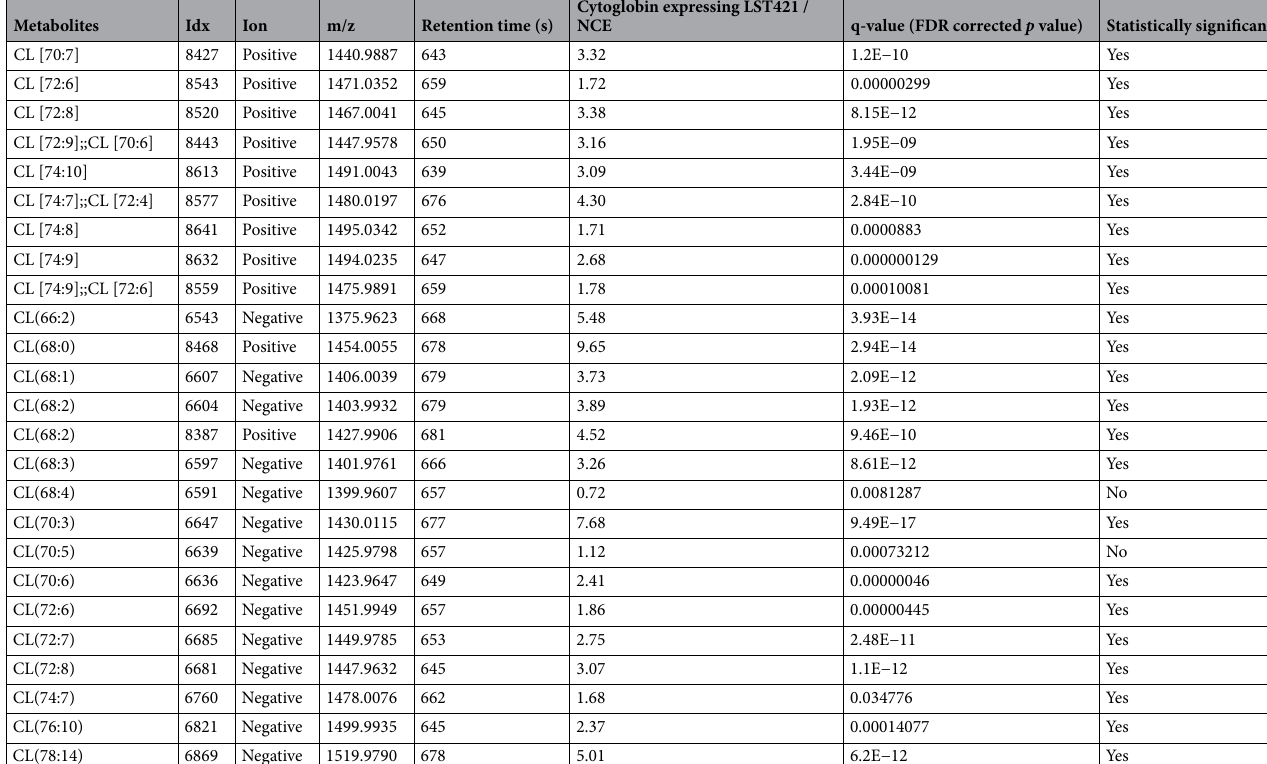
Table 1. Cardiolipin metabolites differentially regulated in cytoglobin (LST421) expressing cells compared to un-transfected control